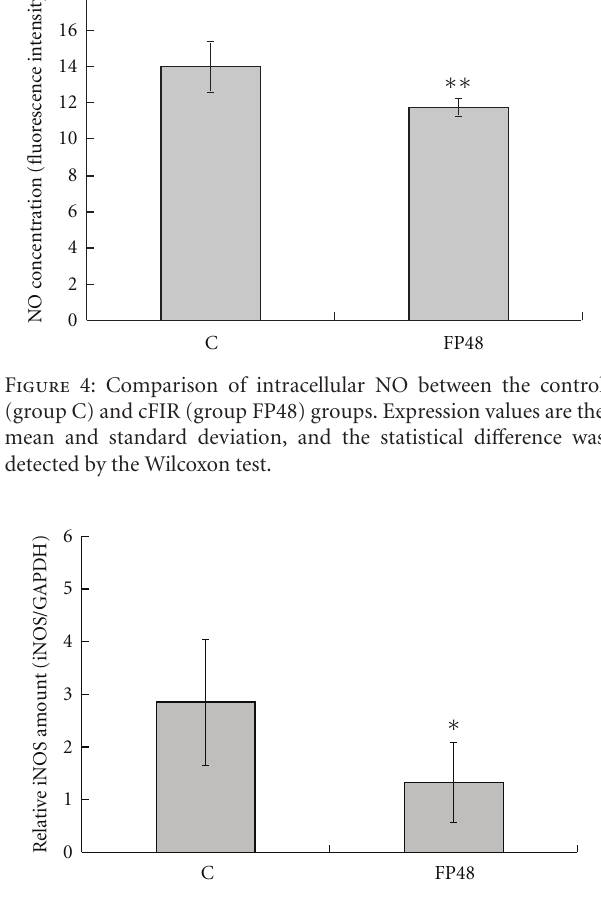
Figure 5: Comparison of inducible nitric oxide synthase between the control (group FP48) and cFIR (group FP48) groups. Expres- sion values are the mean and standard deviation, and the di ff erence between groups was tested using the Wilcoxon